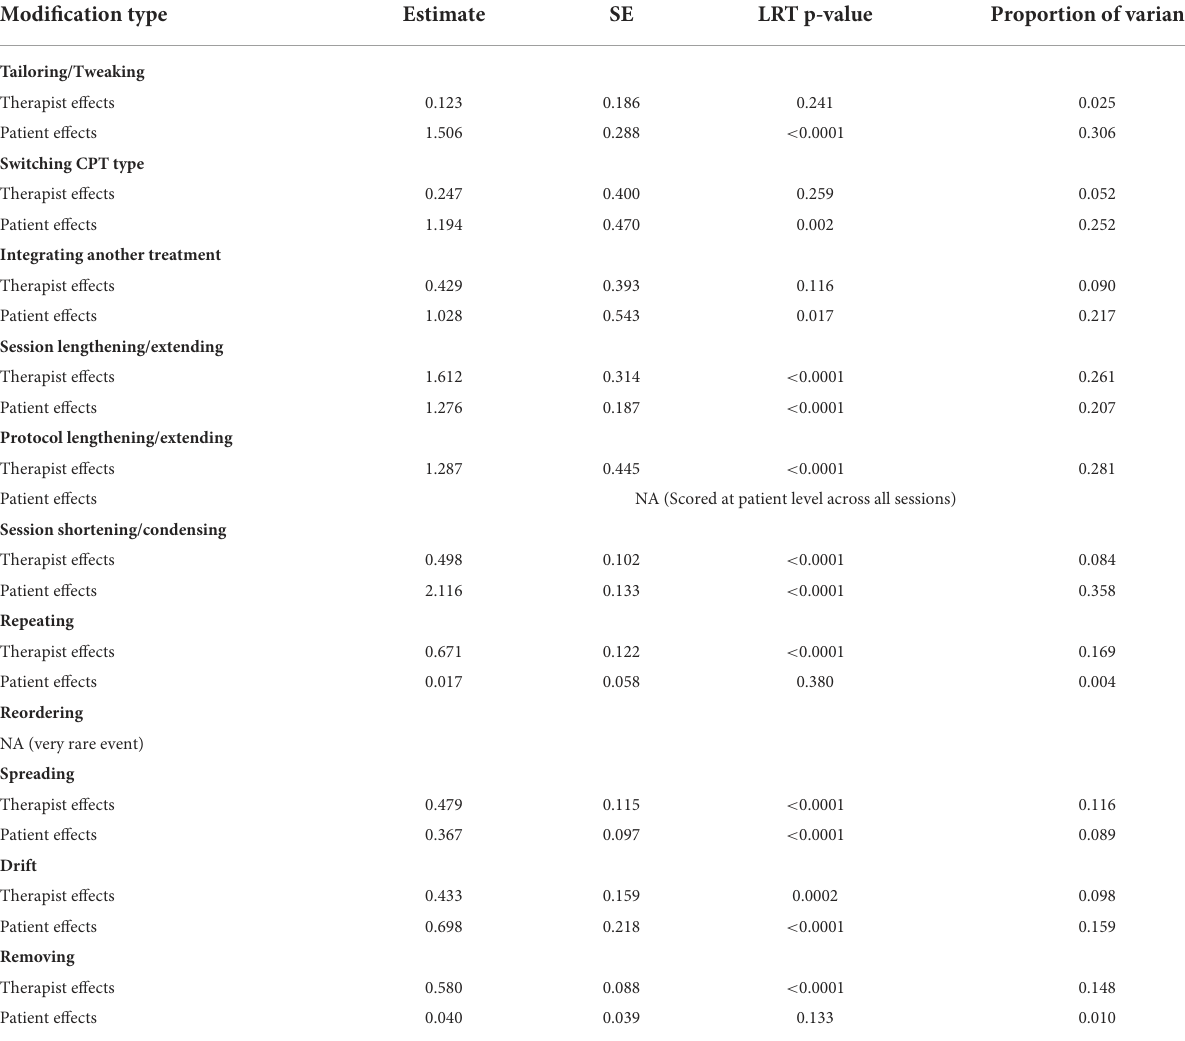
TABLE 4 Estimated variance components for random effects for CPT and